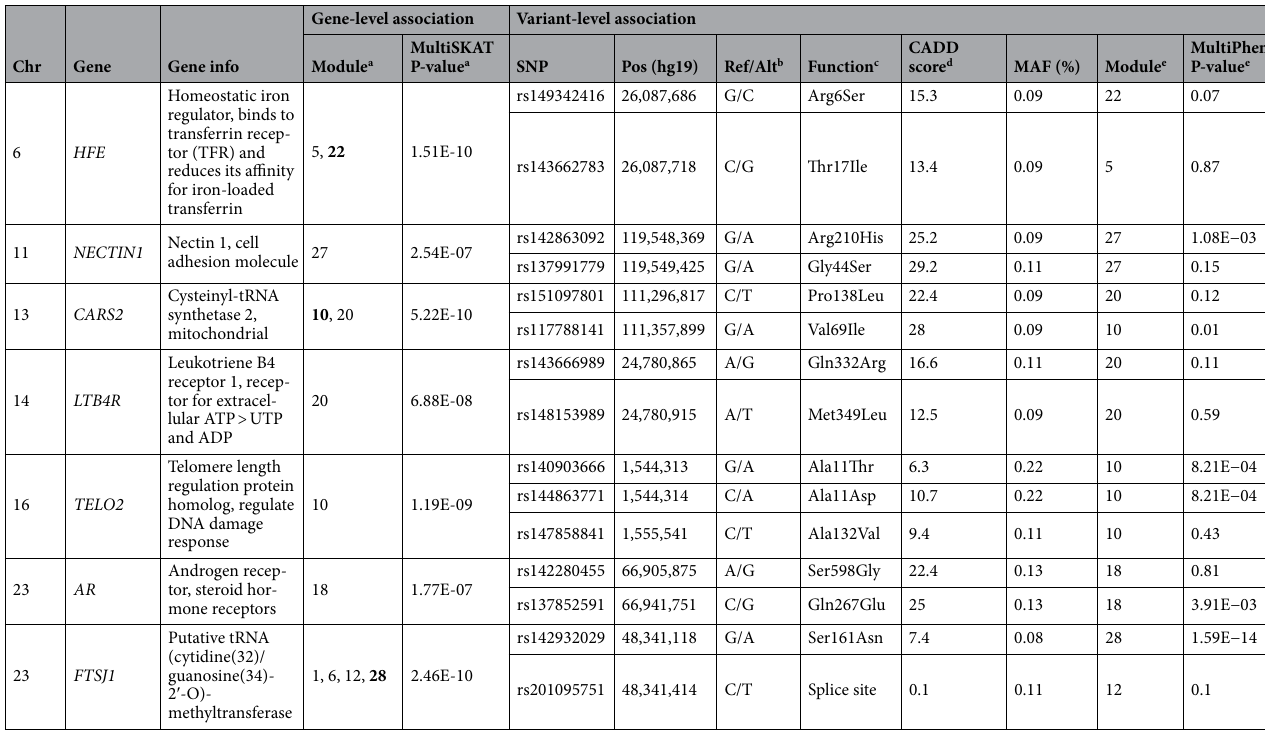
Table 1. Single variant association and functional prediction for variants contributing to the gene-level significance. a For genes associated with multiple facial modules, the most significant module is in bold and only its p-value is shown. b Alleles are listed as alternative/reference alleles on the forward strand of the reference genome. c For missense variant, amino acid substitution is given. d Bioinformatic prediction of variant effect, higher score indicates greater damaging effect. e Variants were tested against all module(s) with gene-level significance, and for genes associated with multiple modules, only the module yielding the smallest p-value in the variant-level test is